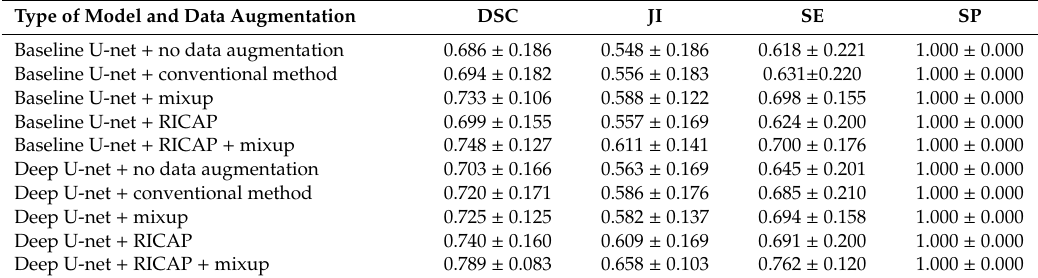
Table 2. Results of quantitative evaluation of automatic pancreas segmentation from the 82 cases using 4-fold cross validation.